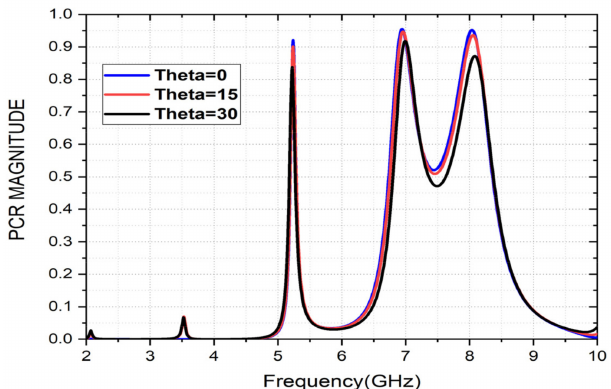
Figure 11. PCR Variation for various incident angles